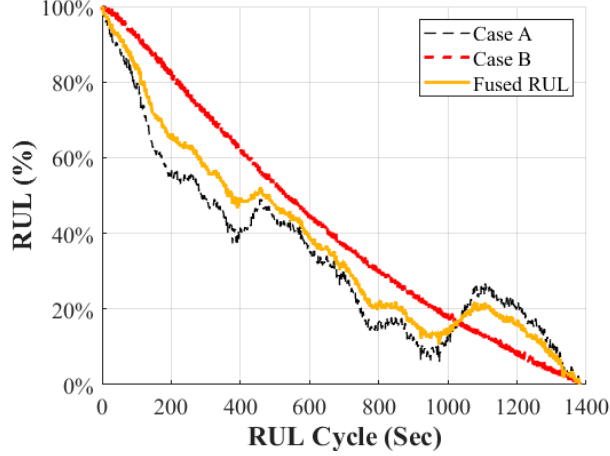
Figure 8. Fused RUL using the Proposed Extended Kalman Filter.